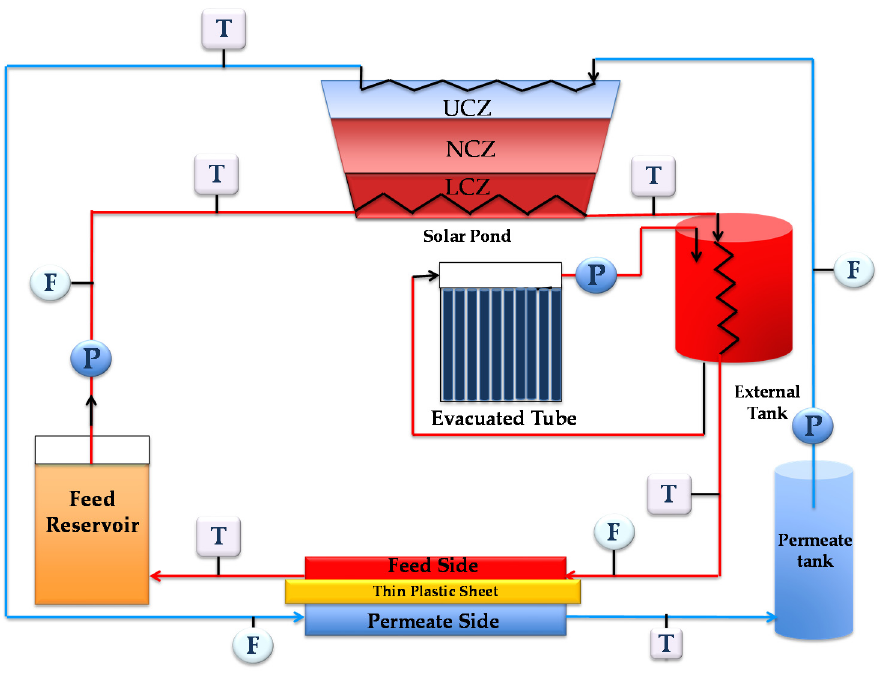
Figure 5. Schematic configuration of the sustainable experimental system using a thin plastic sheet.